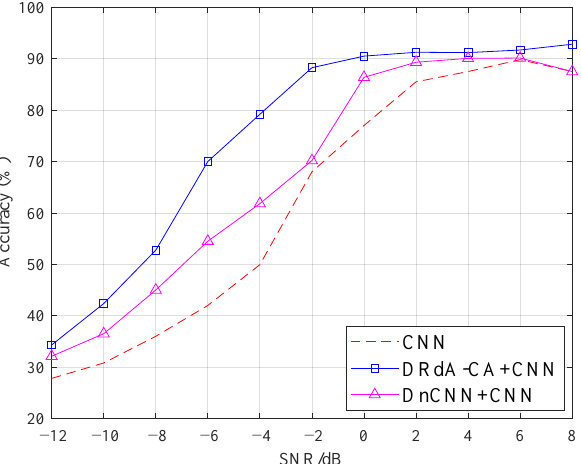
Figure 9. Modulation classification accuracy under different deep learning